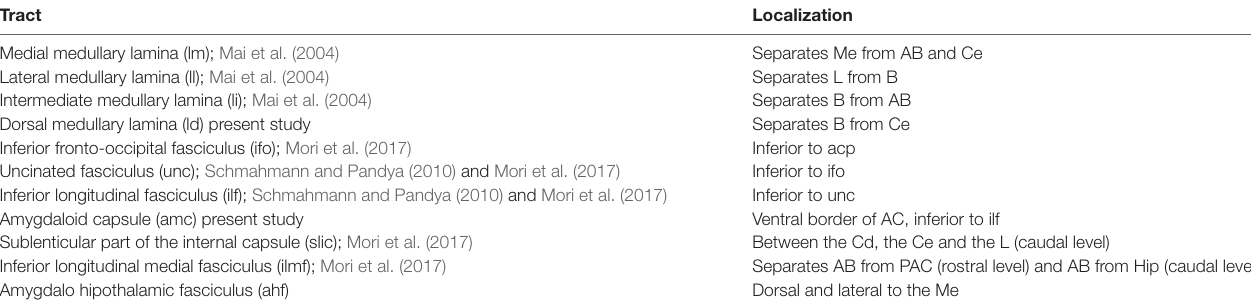
TABLE 1 | Nomenclature and localization of the myelinic tracts present in the amygdaloid complex (AC). Tract Localization Medial medullary lamina (lm); Mai et al. (2004) Separates Me from AB and Ce Lateral medullary lamina (ll); Mai et al. (2004) Separates L from B Intermediate medullary lamina (li); Mai et al. (2004) Separates B from AB Dorsal medullary lamina (ld) present study Separates B from Ce Inferior fronto-occipital fasciculus (ifo); Mori et al. (2017) Inferior to acp Uncinated fasciculus (unc); Schmahmann and Pandya (2010) and Mori et al. (2017) Inferior to ifo Inferior longitudinal fasciculus (ilf); Schmahmann and Pandya (2010) and Mori et al. (2017) Inferior to unc Amygdaloid capsule (amc) present study Ventral border of AC, inferior to ilf Sublenticular part of the internal capsule (slic); Mori et al. (2017) Between the Cd, the Ce and the L (caudal level) Inferior longitudinal medial fasciculus (ilmf); Mori et al. (2017) Separates AB from PAC (rostral level) and AB from Hip (caudal level) Amygdalo hipothalamic fasciculus (ahf) Dorsal and lateral to the Me Avendaño and Reinoso-Suarez (1975). For abbreviations see list for